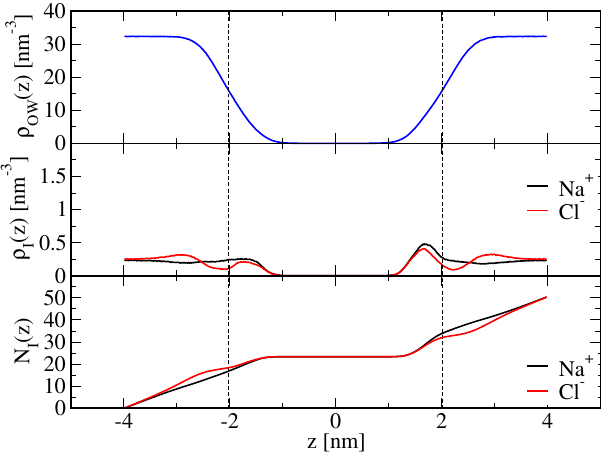
Figure 3. As Figure 1, but for simulation S NaCl (m2,wc), i.e., a simulation based on a modified force field (Table 7). The corresponding apparent binding constants are reported in Table 2.